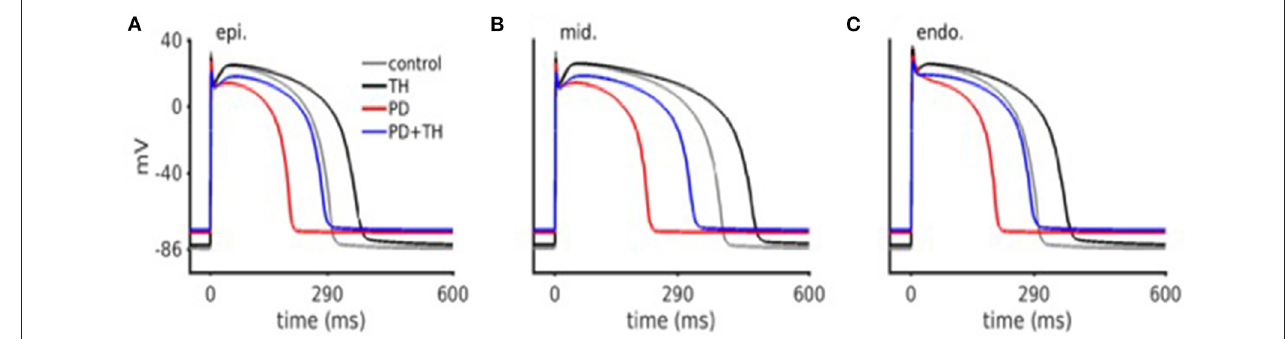
FIGURE 5 | In silico cardiac action potential. Ischemic action potentials are abbreviated, as well as have lower upstroke velocity. TH treated action potentials are prolonged (as compared to control), and have a lower upstroke velocity. Both PD and TH action potentials have an elevated resting membrane